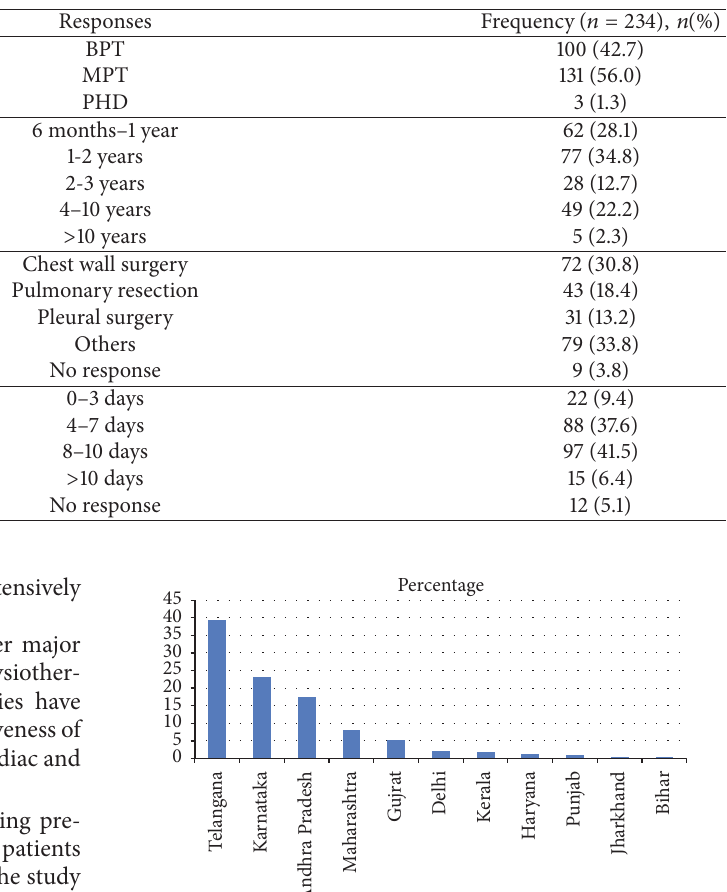
Table 1: Professional profile of questionnaire responders.